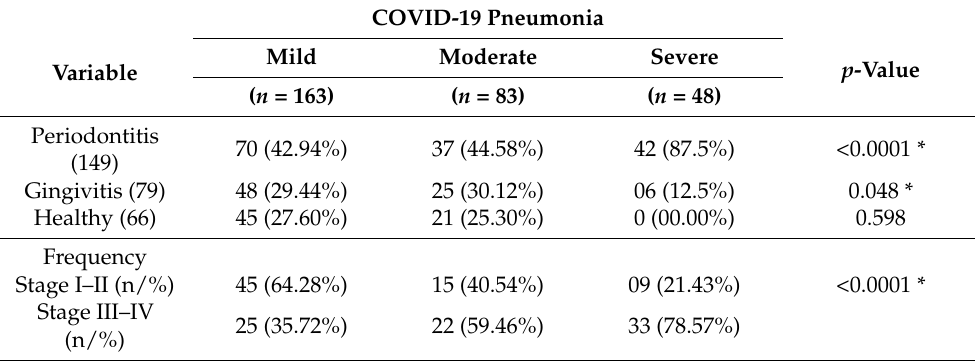
Table 2. Comparison of periodontal parameters between the three COVID-19 pneumonia